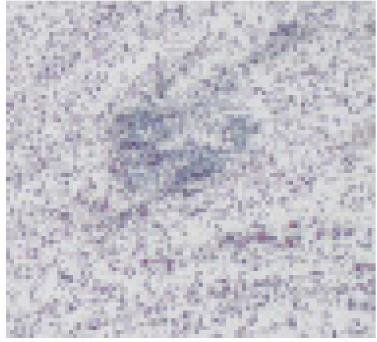
Figure 11. Part of the microstructure layer showing the object with the noise surrounding it. The object can be detected by a slightly different appearance and high